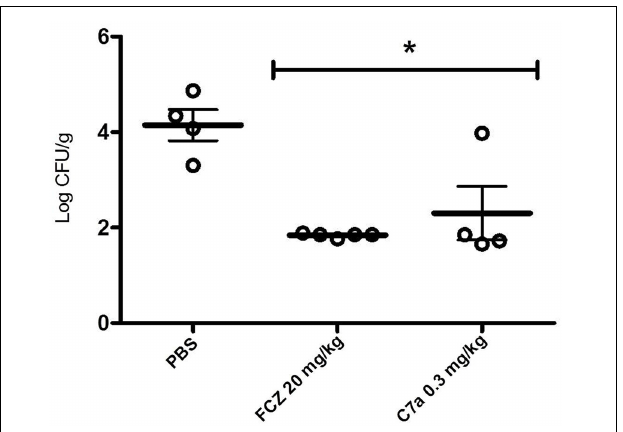
FIGURE 4 | Cyclopalladated C7a treatment of disseminated candidiasis. The disseminated candidiasis was induced by intravenous injection of 3 × 10 6 C. albicans ATCC 10231 yeasts in female BALB/c mice. Intraperitoneal treatment was carried out every 24 h for 7 days after infection, and animals were inoculated with PBS, 0.3 mg/kg of C7a, or 20 mg/kg of FCZ. Treatment was evaluated by determination of the number of colony forming units (CFU) per gram of tissue of the kidneys, 8 days after infection. Animals are represented individually, and 1 representative experiment out of 3 is showed. ∗ Indicates statistical significance (ANOVA with post-Tukey test, P < 0.05) compared to PBS-inoculated group. of 78% and treatment with 20 mg/kg of FCZ produced ( Figure 5 ).